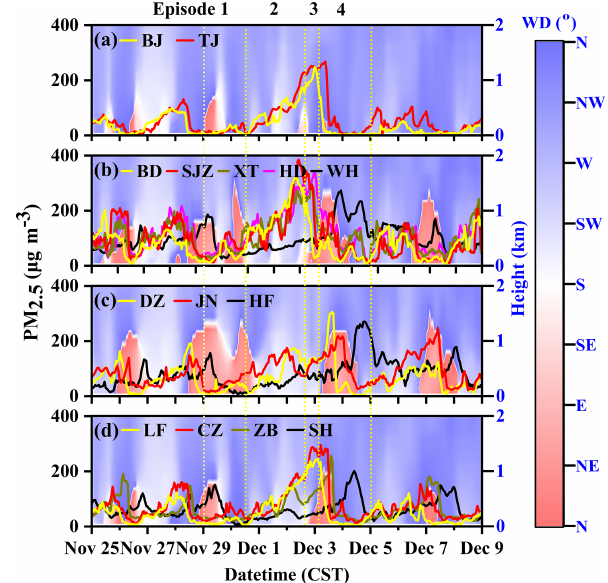
Figure 3. Surface PM 2 . 5 observations from different cities: (a) Bei- jing (including Tianjin) and its (b) southwest cities, (c) southeast cities, and (d) east cities for the period 25 November–9 Decem- ber 2017. Superimposed colors represent the time-varying profiles of the simulated wind fields in Beijing, Baoding, Dezhou, and Lang- fang,